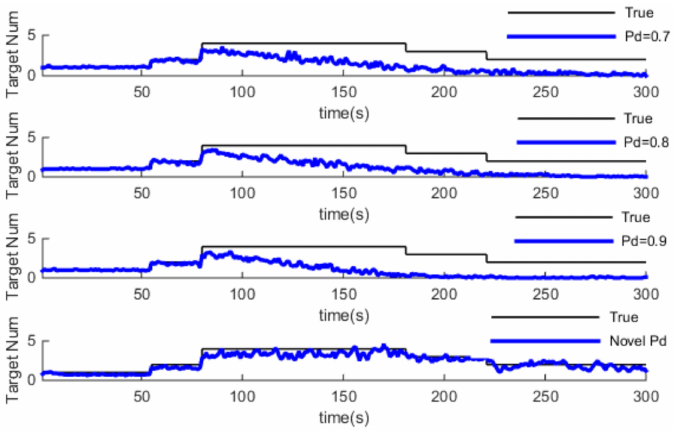
Figure 8. Comparison of target number estimation with different P d in clutter intensity κ k =